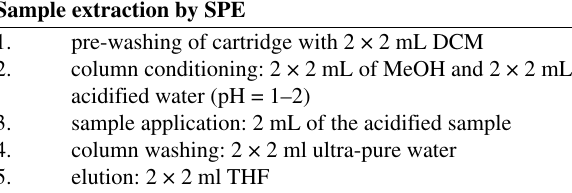
Table 2. Sample extraction by SPE (using HLB Supelco ® cartrid-